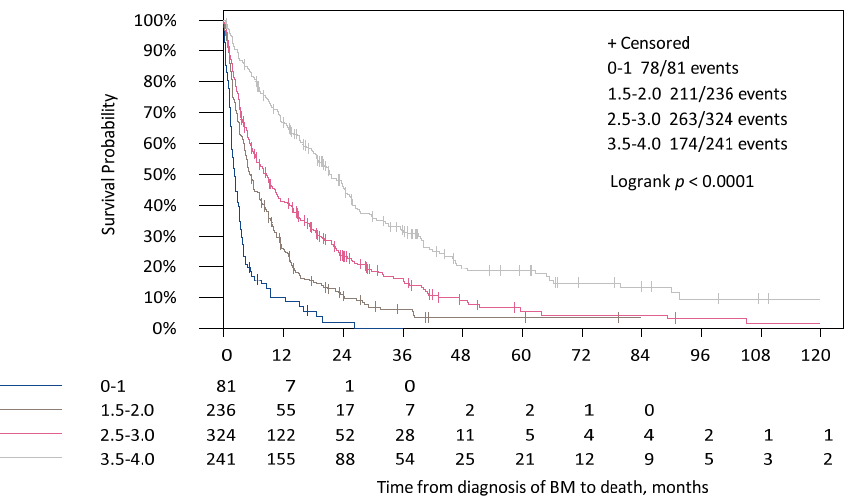
Figure 3. Survival times for the time from diagnosis of BM to death in the four categories of the updated Breast-GPA Score.